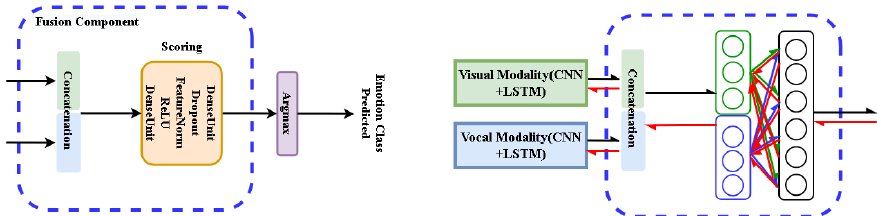
Figure 5. Distorted gradients backpropagation in some modality since the gradients from fused layer makes impact on gradients flow into neural weights of both